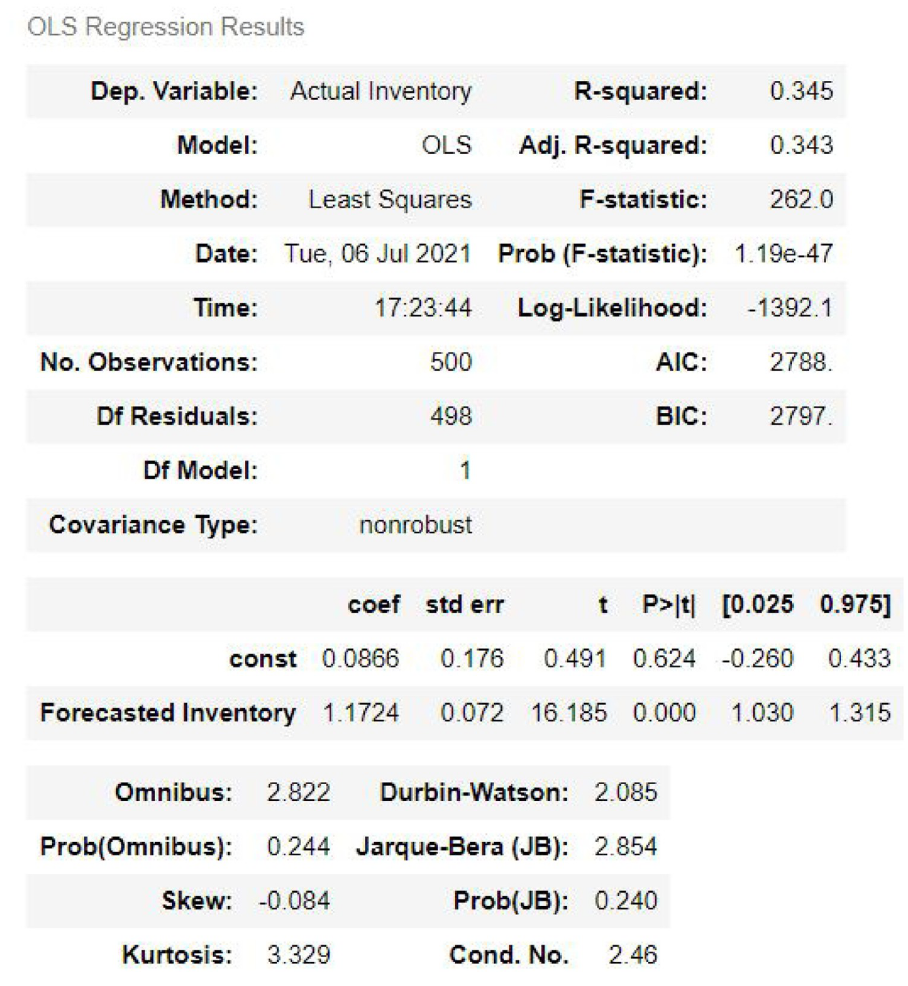
Fig 4. OLS regression